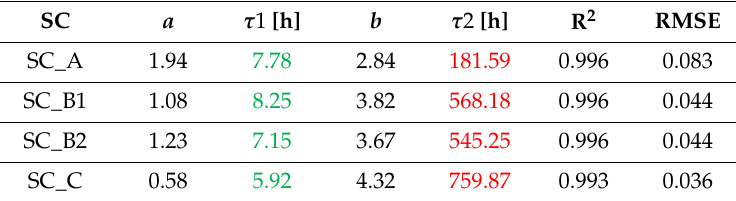
Table 6. Voltage percentage variations for the most performing tested SCs, kept under charging at 5 V for one and five hours, and for the LiPo batteries.